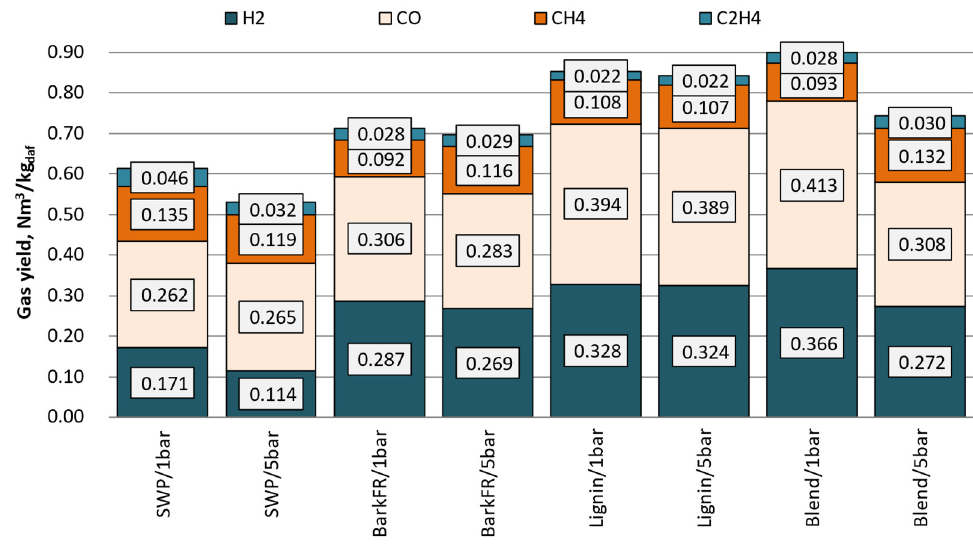
Energies 2022 , 15 , 1395 Figure 3. The yield of the main constituents of the producer gas. Figure 3. The yield of the main constituents of the producer gas.